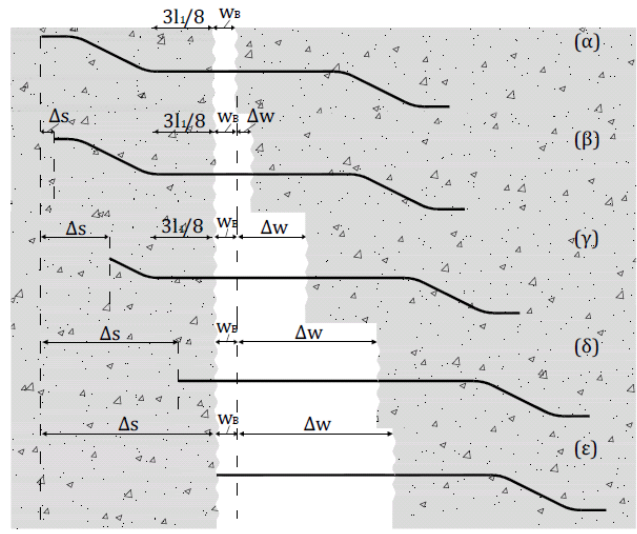
Figure 3. Phases [( α )–( ε )] of extraction for a fiber, embedded in concrete, due to formation of a Figure 3. Phases [(α)–(ε)] of extraction for a fiber, embedded in concrete, due to formation of a perpendicular crack (initial w B + ∆ w). Extraction length ( ∆ s) increases until fiber is fully extracted. perpendicular crack (initial w B + Δw). Extraction length (Δs) increases until fiber is fully extracted .